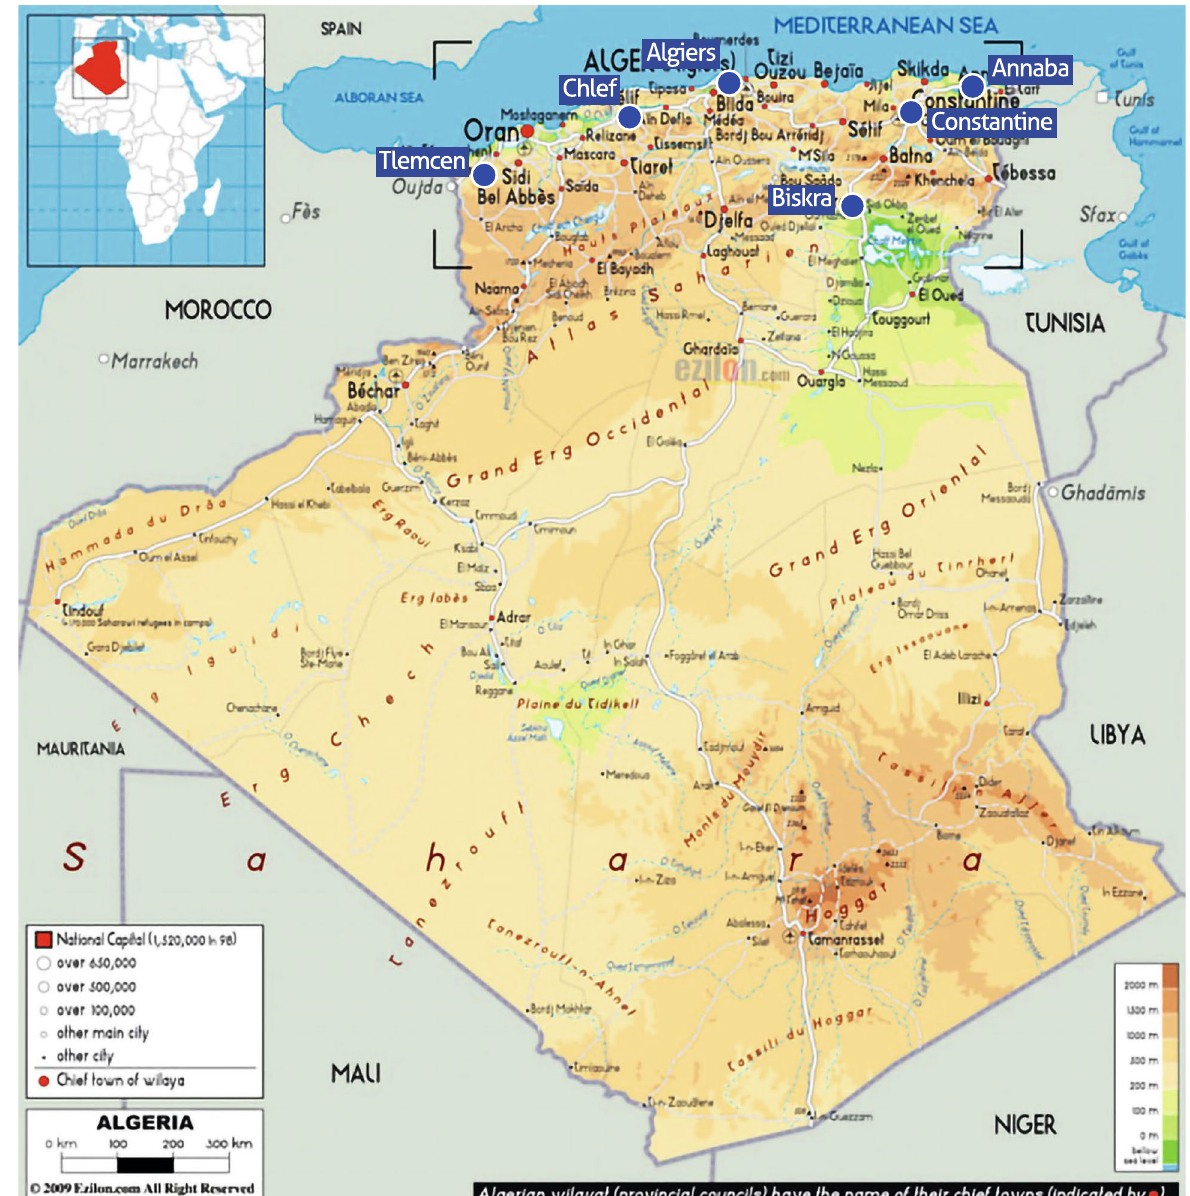
Fig. 2 Geographical distribution of the study corpus (blue circle) (Source: http:// www. vidia ni. com/ large- physi cal- and- road- map- of- alger